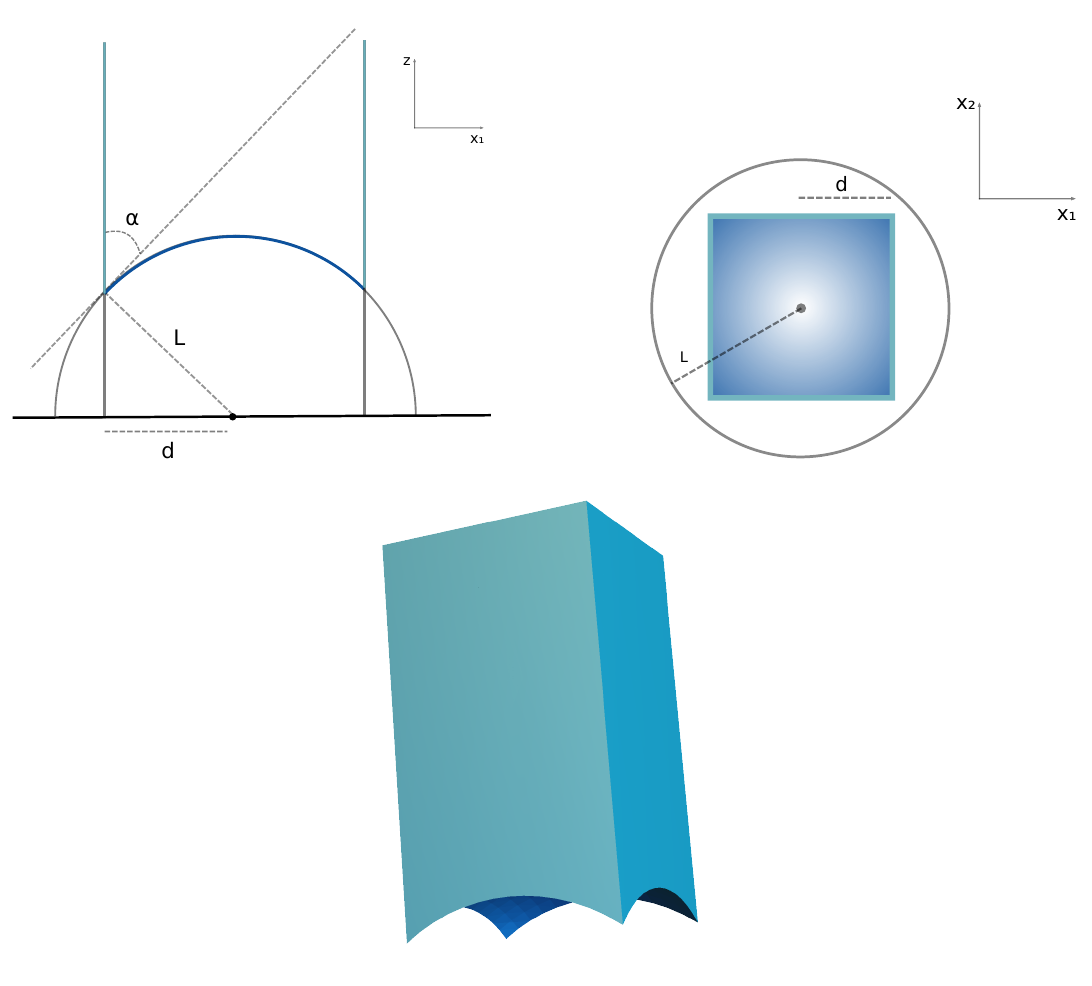
Figure 8: A simple three-dimensional polyhedron composed of a single hemisphere of radius L centered at the origin of the upper-half space and four vertical walls with a square cross-section whose half-length is denoted by d . The dihedral angle α is given by cos α = d . For the polyhedron to have finite volume the square in the top- L right view has to be inscribed in the circle, requiring d with k an integer, leaves as the only possibilities k = 3,4. At the bottom we show a 3d rendering of the k = 3